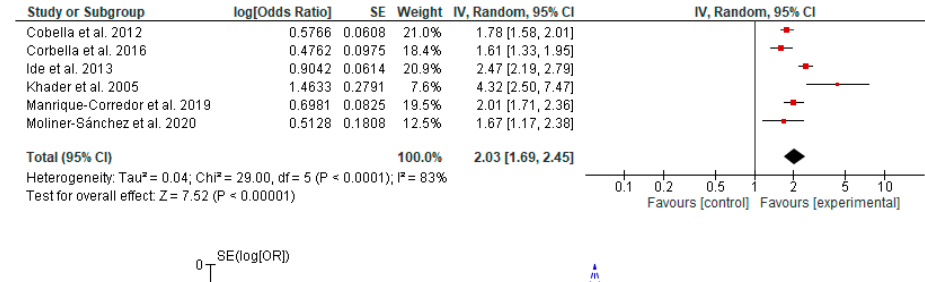
Figure 4. Forest plot and funnel plot of the association between the risk of PB with LBW in newborns with PD in pregnant women. 3.5. GRADE Analysis When evaluating the included studies, it was observed that there is low and moder- ate certainty in the association of PD in pregnant women with PB and LBW in newborns (Table 5).